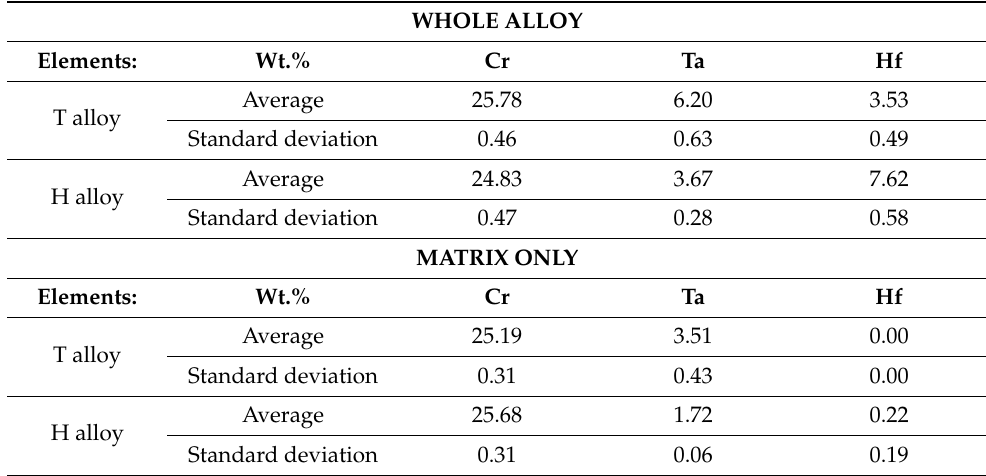
Figure 1. As-cast microstructures of the two alloys just after their elaboration by high frequency induction melting and solidification (left: T alloy, right: H alloy, top: general view at ×250, bottom: detailed view at ×1000, bottom right corners: more detailed views at ×2000). Table 1. Chemical compositions of the two as-cast alloys (wt.%, SEM/EDS; five ×250 full frame analyses, that is to say about 5 × 600 µm 2 ) and of their matrixes (wt.%, SEM/EDS; five spot analyses).